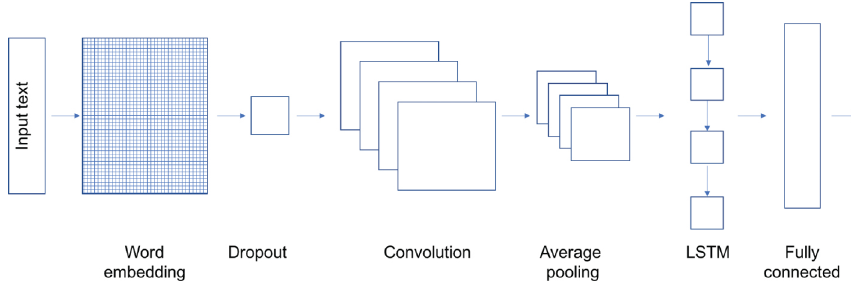
Figure 1: Deep network architecture.